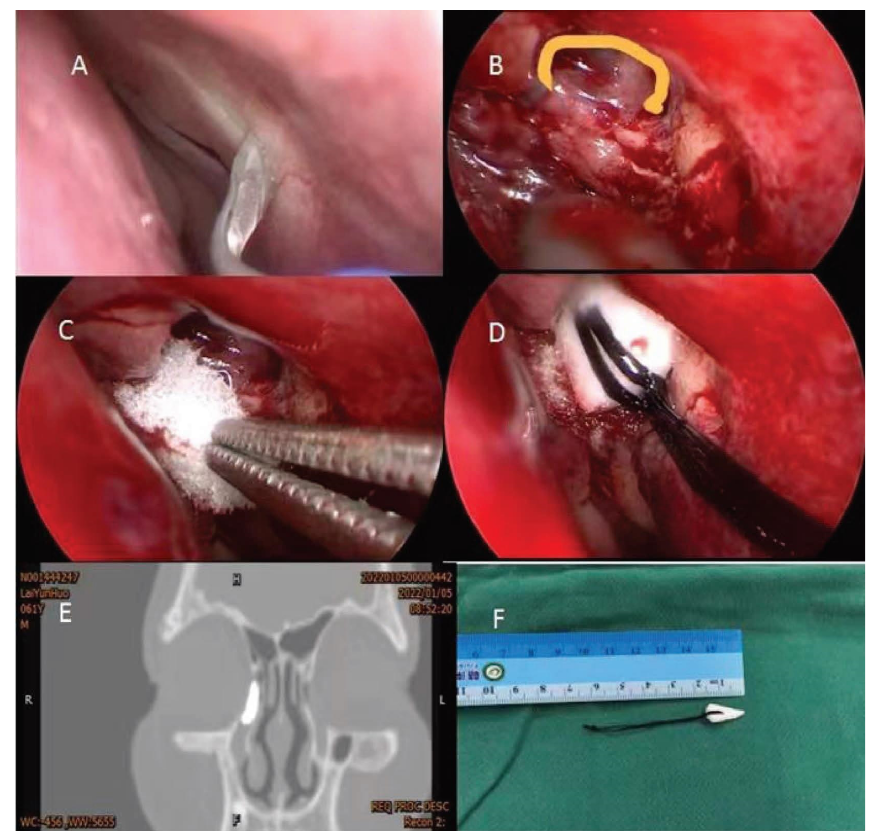
Figure 1: Methods of modifed endoscopic dacryocystorhinostomy. (a) Reduction of bleeding from the mucosal incision after flling with 1mg/ml epinephrine hydrochloride, ephedrine hydrochloride, and nitrofurazone nasal drops. (b) Use of a “C”-shaped lacrimal sac incision rather than an “I”-shaped lacrimal sac incision. (c) Application of a gelatin sponge to the anastomosis of the lacrimal sac and nasal mucosa rather than suturing. (d) Filling of the lacrimal sac with a conical expansion sponge for 1 week. (e) Outcome of dacryocystorhinography. (f) Illustration of a conical expansion sponge. Table 1: Demographic and clinical characteristics of patients who underwent modifed and routine endoscopic dacryocystorhinostomy.